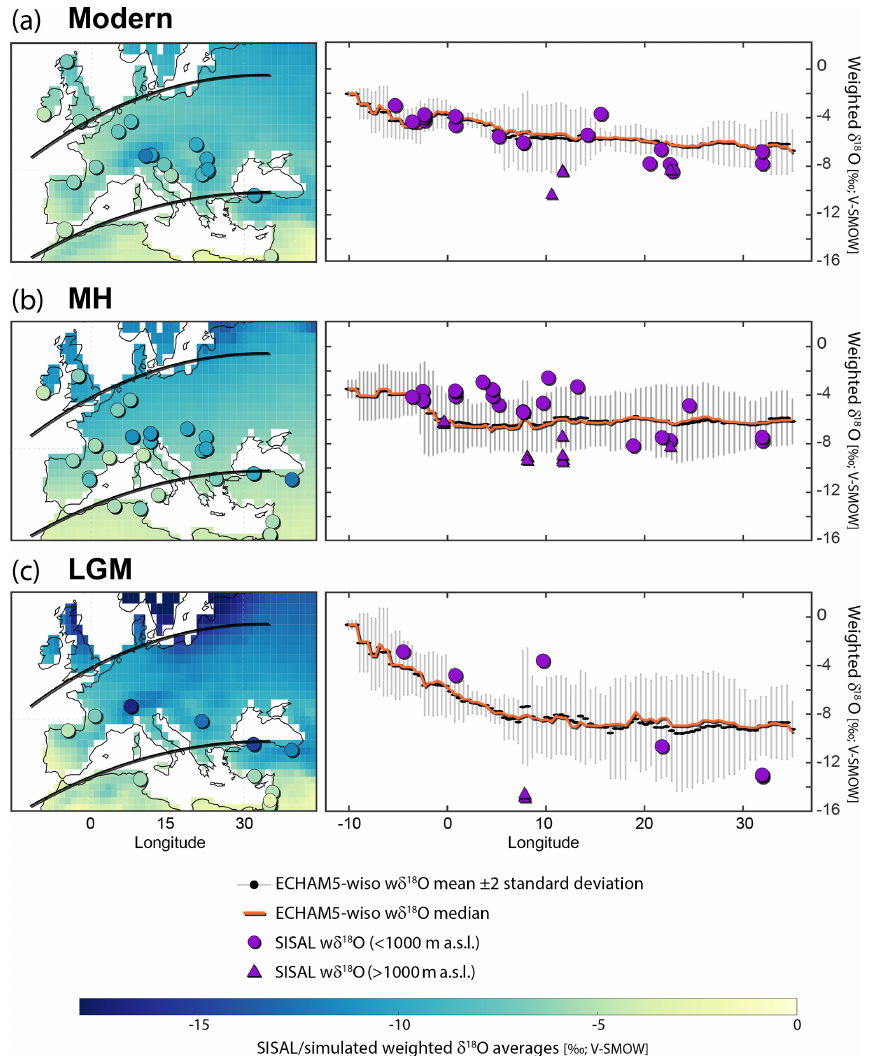
Figure 8. Longitudinal isotopic transect for Europe during the (a) modern (1958–2013CE), (b) Mid-Holocene (MH; 6 ± 0 . 5kyrBP) and (c) Last Glacial Maximum (LGM; 20 ± 1kyrBP) periods. Details as in caption of Fig.